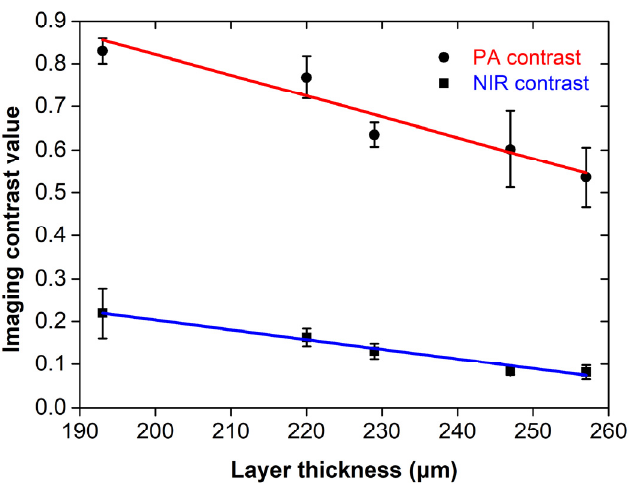
Figure 5. Plot of imaging contrast values for PA (black circles) and NIR (black squares) techniques as a function of the average paint layer’s thickness. Error bars represent the standard error of the mean out of five measurements. Red and blue lines show the linear fitting of the respective data points. Table 2. Fitting parameters for the linear models ( y = ax + b ) presented in Figure 5, describing the imaging contrast reduction as a function of the overlying layer’s thickness.